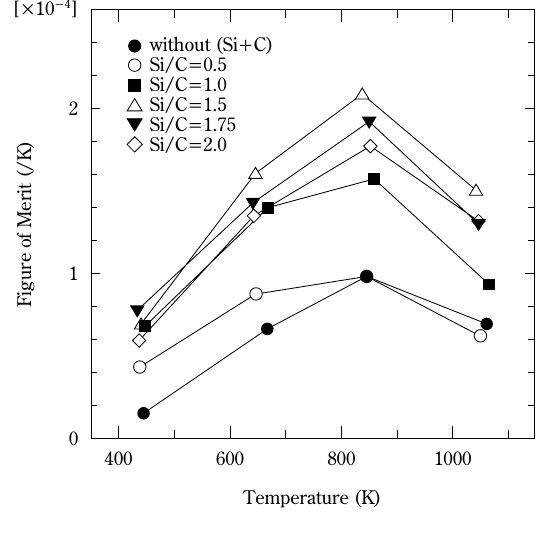
Fig. 8 Temperature dependence of the figure of merit for the sin- tered p-type Fe 0.92 Mn 0.08 Si 2 with 4 mass%(Si (cid:4) C) at various Si/C ratios.